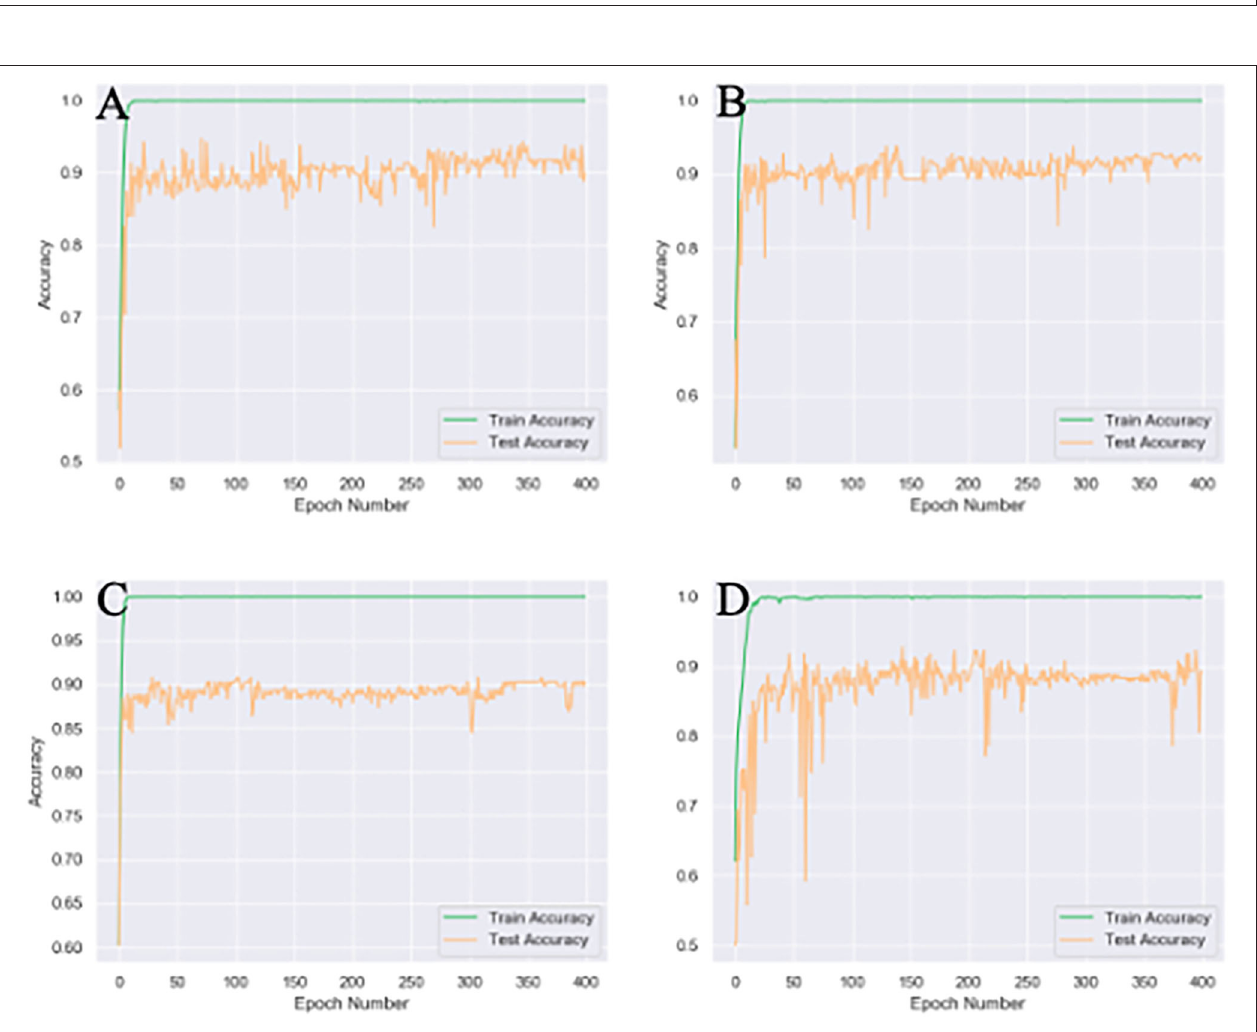
FIGURE 4 | Different attention unit MobileNetV2 training results of 4x traditional augmentation. (A) Spatial attention (SA) accuracy curve (89.8% testset accuracy). (B) Channel attention (CA) accuracy curve (92.2% testset accuracy). (C) Accuracy curve without any attention (89.8% testset accuracy). (D) , Mix attention (MA) accuracy curve (89.3% testset accuracy). The accuracy curve fluctuate more violently without any attention module and the final accuracy is the lowest.